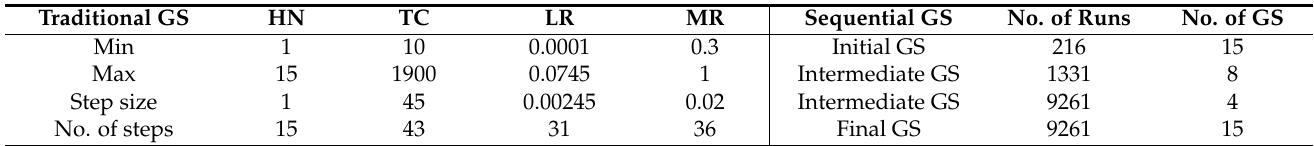
Table 14. Comparison of the number of ANNs tested between traditional grid search and sequential grid